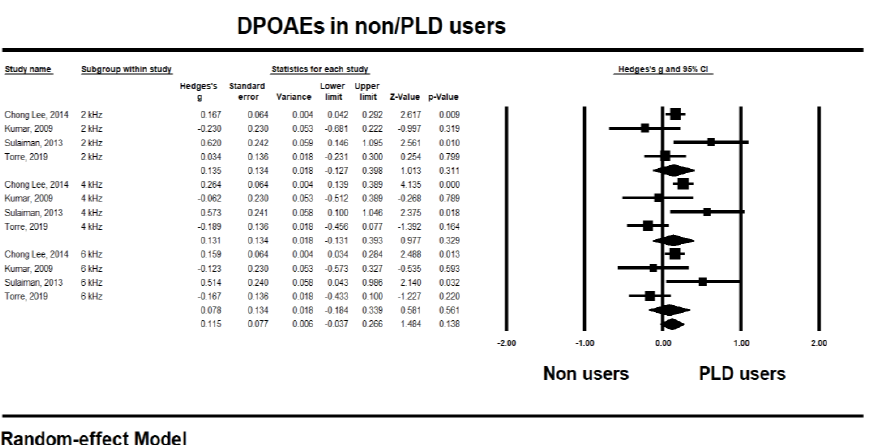
Figure 5. Long-term hearing changes for the distortion product otoacoustic emissions (DPOAEs) amplitude at 4, 6, and 8 kHz center frequencies after music exposure.